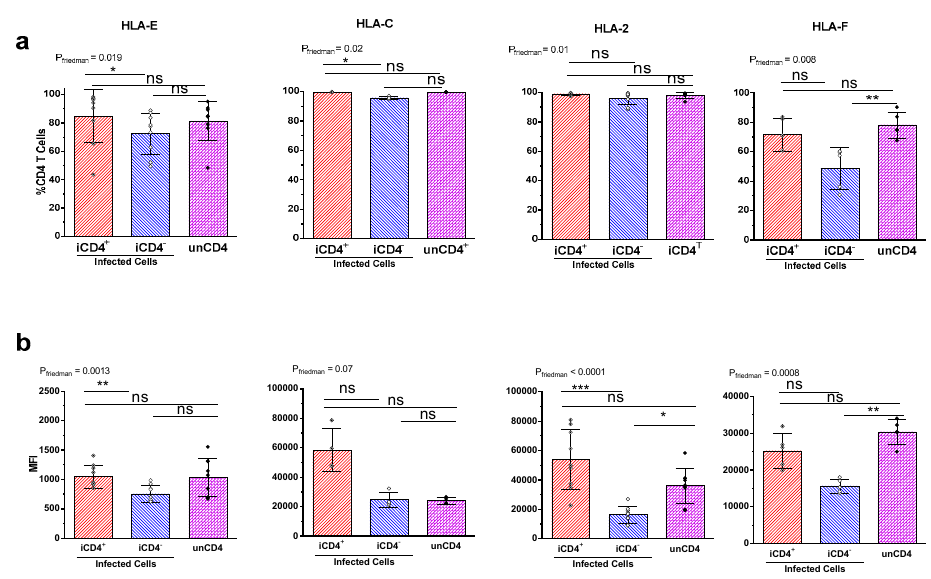
Figure 6. Expression profile of the human leukocyte antigen (HLA) molecules HLA-E, HLA-C, HLA-A2, and HLA-F on CD4 + T cell subsets. ( a ) The frequency of HIV-infected p24 + CD4 + (iCD4 + ), p24 + CD4 − (iCD4 − ) and uninfected (unCD4) T cells expressing HLA-E ( n = 9), HLA-C ( n = 4), HLA-A2 ( n = 9), and HLA-F ( n = 5); ( b ) the mean fluorescent intensity (MFI) of iCD4 + , iCD4 − and unCD4 cells expressing the indicated ligands for the same study subjects as in ( a ). The percentage and MFI of cells expressing the indicated ligand is represented on the y-axis. * p < 0.05; ** p < 0.01; *** p < 0.001.